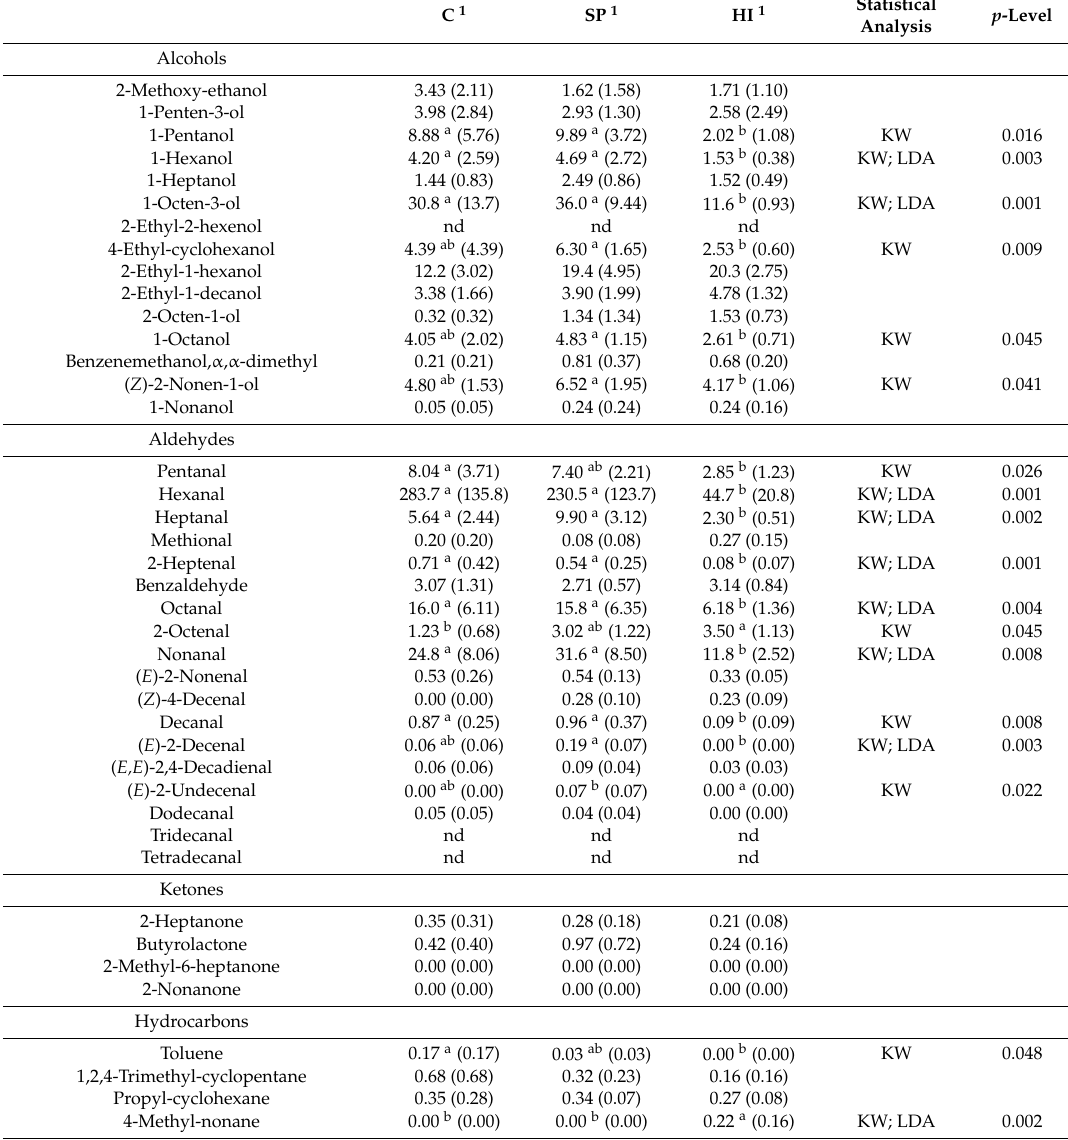
Table 2. The composition of the volatile profile of chicken breast meat fed with three di ff erent diets in Trial 2 ((Control (C) vs. Spirulina (SP) vs. Hermetia illucens (HI)) (results expressed as ng /